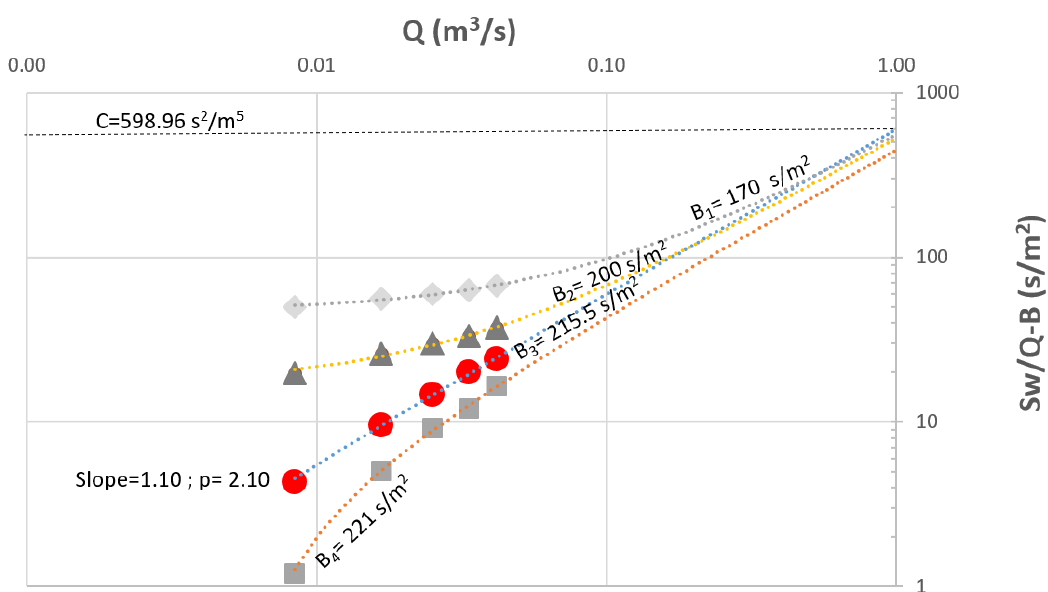
Figure 6. An Example of log-log plot of (S w / Q − B) versus discharge (Q) to determine the well losses parameters B, C, and p according to the Rorabaugh (1953) [1] method. For the selected value of B (B = 215.5 s / m 2 ), the plotted points exhibit a straight line. The slope of this line is 1.10, yielding the value of p = 2.10. Intersection of this line, with the vertical axis Q = 1, gives the value C = 598.96 s / m 2 .